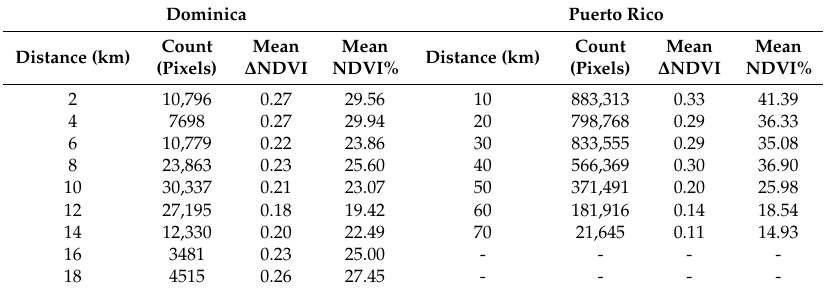
Table 8. The vegetation index statistics of different distance for Dominica and Puerto